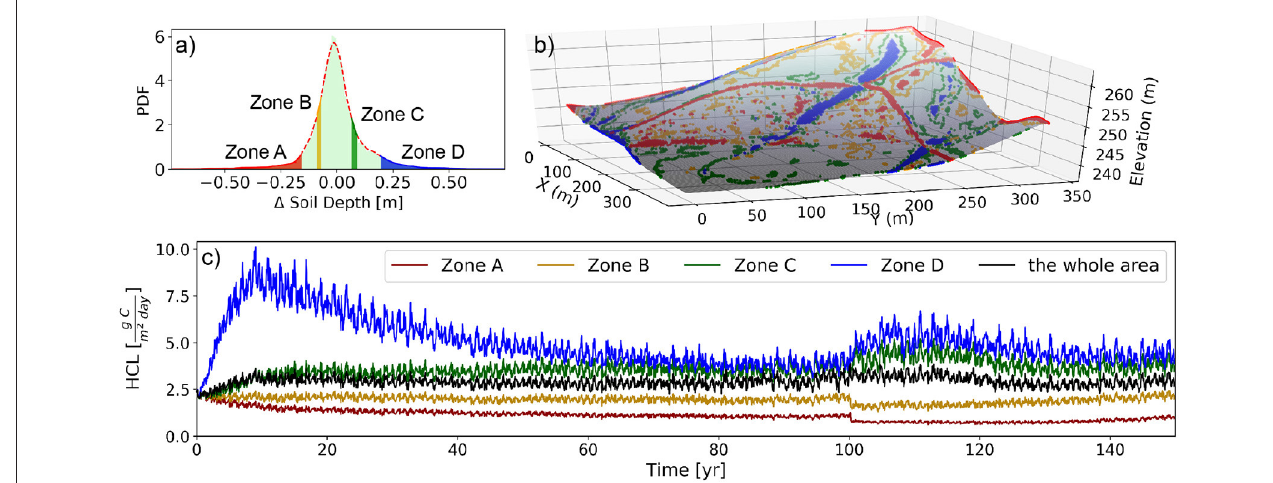
FIGURE 2 | Illustration of spatial variability of the dynamics of heterotrophic carbon loss (HCL). The HCL value at each 2-D grid box is the vertical integration of the HCL through the profile, which corresponds to different soil depth at different locations. (a) Probability density function (PDF) of soil thickness change due to erosion and deposition after 150 years simulation on the landscape along with four selected zones (5% of the total area each) for analysis, corresponding to the high erosion (Zone A) and deposition (Zone D), and moderate erosion (Zone B) and deposition (Zone C). (b) The location of the four zones on the topography. (c) The temporally varying spatial mean values of the HCL of the four zones and the whole watershed. The mechanical-mixing is implemented at year 100. Note (a,b) are adapted from Yan et al. (2019) with permission from Wiley.